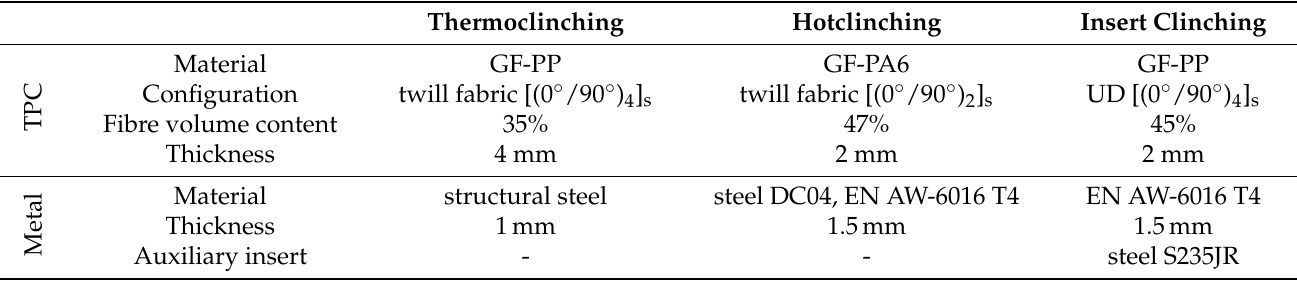
Table 1. Specification of the utilised materials.